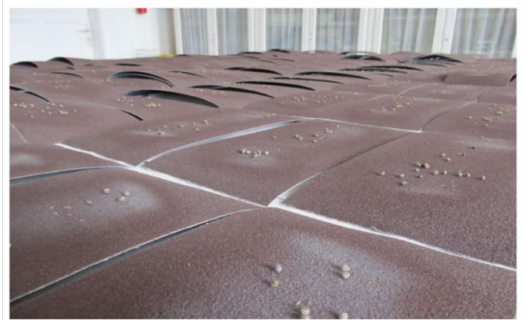
Figure 1. Seeds of Galium aparine, glued on sandpaper (25/10 cm, p = 60 (kL361 J-Flex Klingspor) (Photo: Osman Mohammed, MATE University, Institute of Plant Protection, Hungary, Gödöll˝o, 2019).